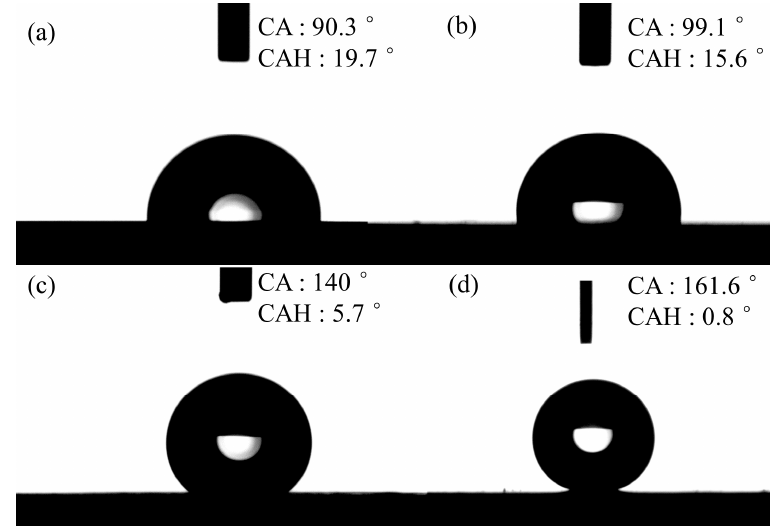
Figure 4. Contact angle of water on the polished Q235 carbon steel surface ( a ), polished steel surface after modification of PFTEOS ( b ), microstructured steel surface ( c ), and structured steel surface after modification of PFTEOS ( d ).